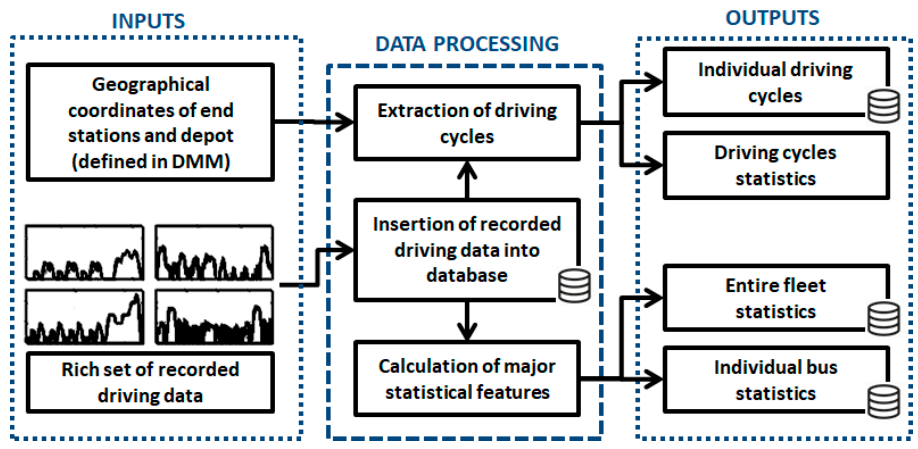
Figure 3. Flowchart of Data Post-Processing Module (DPPM).